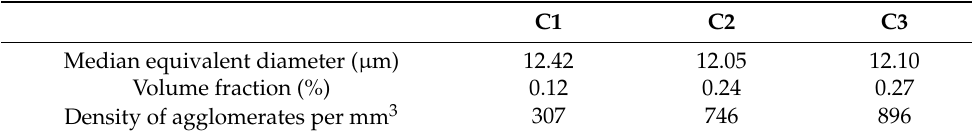
Figure 2. Volume rendering of the agglomerates in ( C1 – C3 ) based on µCT imaging and image analysis. Table 3. 3D image analysis of the agglomerates in C1 to C3.